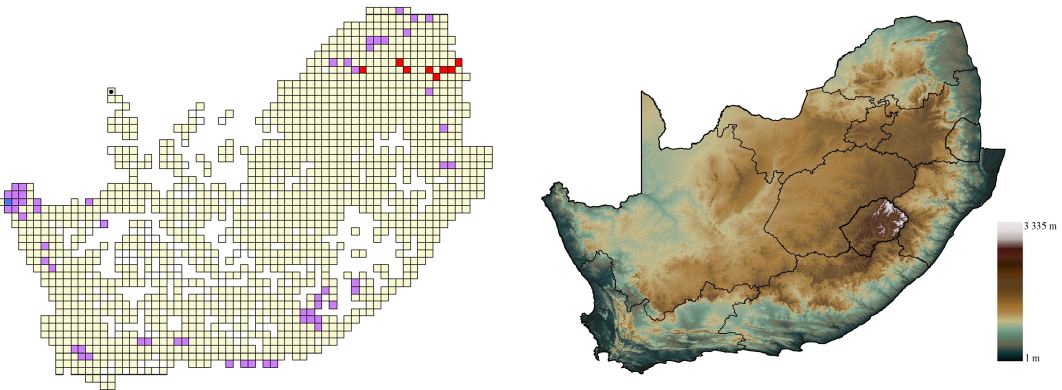
Figure 6. CANAPE results: Map showing QDGS squares within the Southern African countries that exhibit neoendemism (red), paleoendemism (blue), and mixed endemism (purple) levels of gekkonids. Topographical map of the Southern African countries shown on the right (created by G.K.N.).